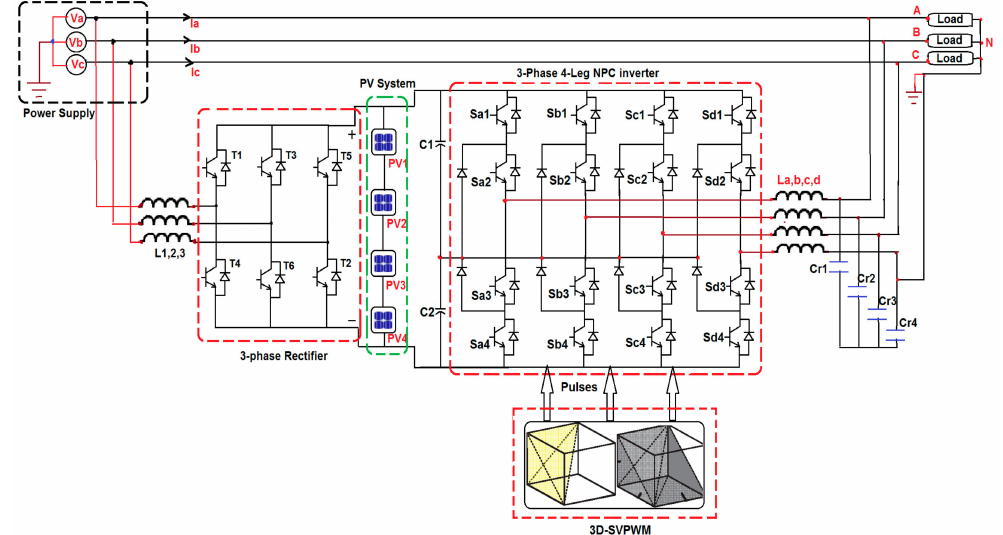
Figure 1. Power structure of 3-phase 4-wire (leg) NPC inverter with PV-UPQC